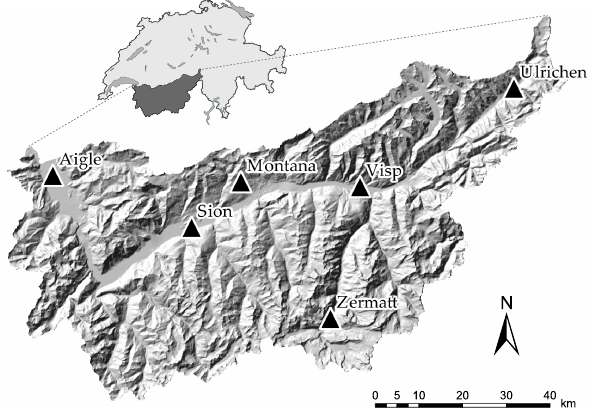
Figure 1. Position of the six weather stations of interest (Aigle, Montana, Sion, Ulrichen, Visp, and Zermatt) in the upper Rhône catchment in Switzerland.